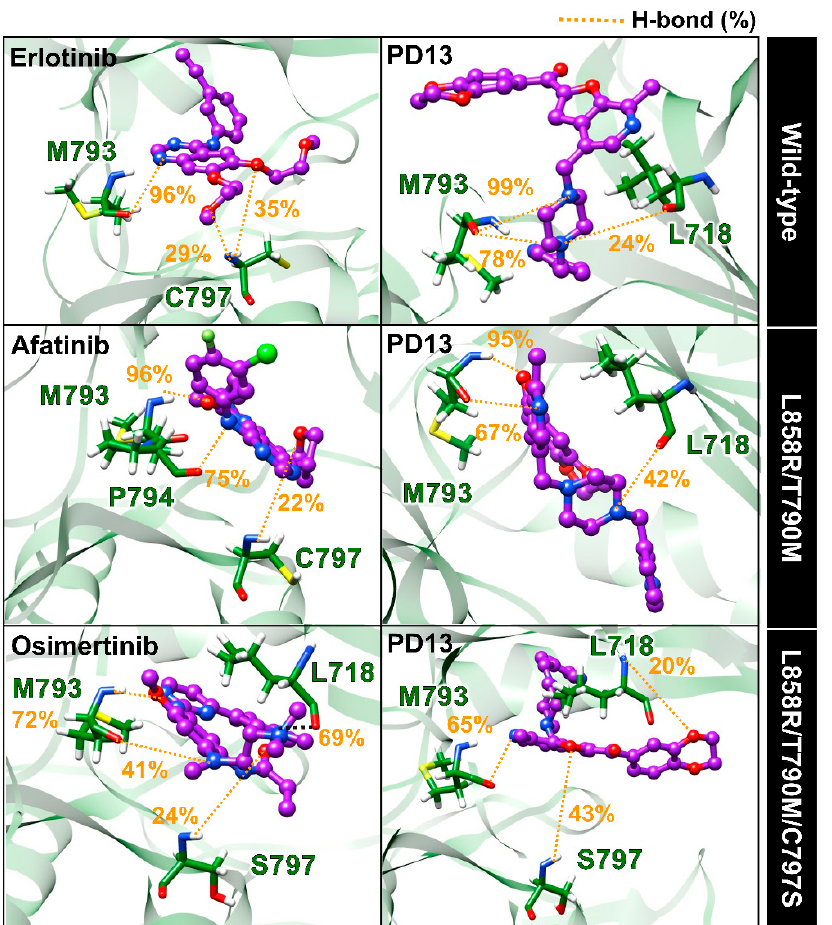
Figure 6. The three-dimensional representative structures showing a percentage of the H-bond occupations of PD13 and drugs with EGFRs, drawn from the last snapshot of run1. The yellow dashed lines indicate H-bond formation.